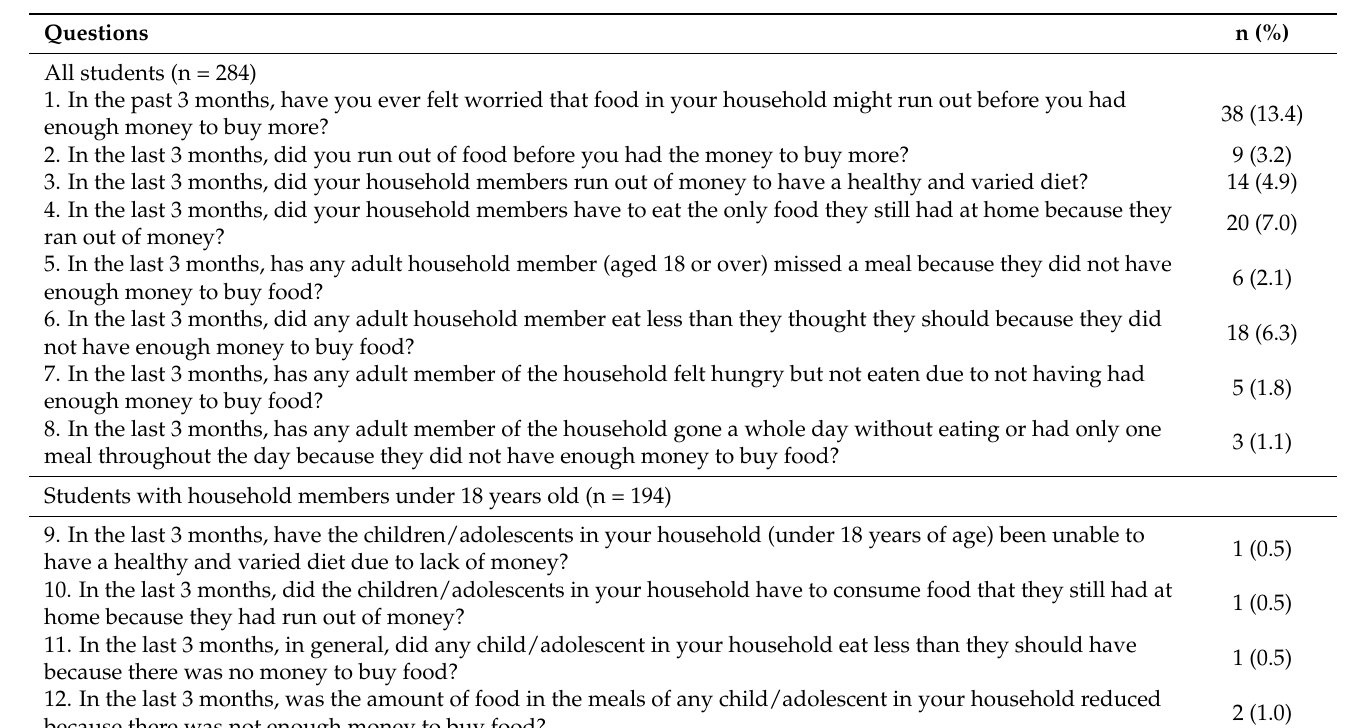
Figure 1. Prevalence of food security by category (%). Table 2. Percentage of affirmative answers provided by students for the food insecurity